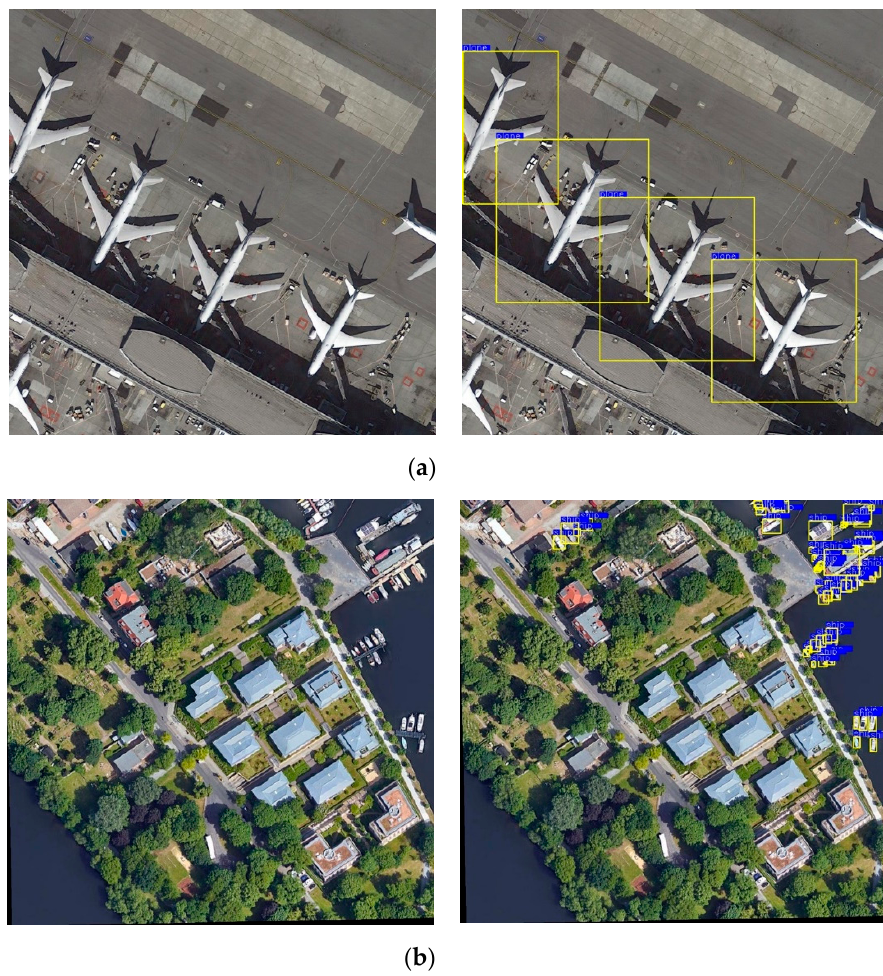
Figure 8. The final calibration and clustering results of the datasets: ( a ) airplanes; ( b ) ships.